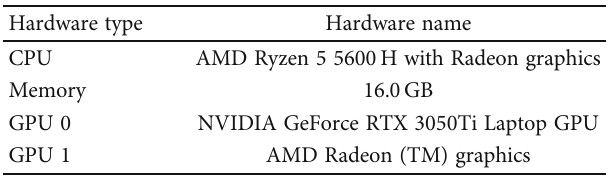
Table 2: Hardware